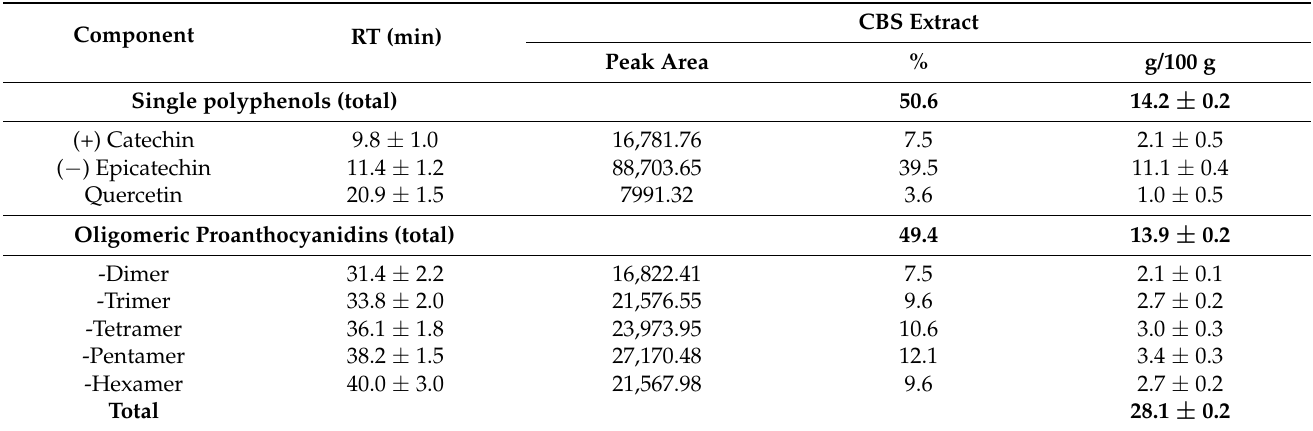
Table 10. HPLC-DAD analysis of cocoa bean shell-oligomeric proanthocyanidin-rich